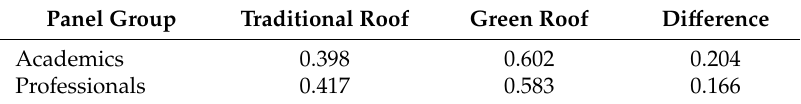
Table 5. Final ranking from Analytic Hierarchy Process (AHP) of two roof solutions. Panel Group